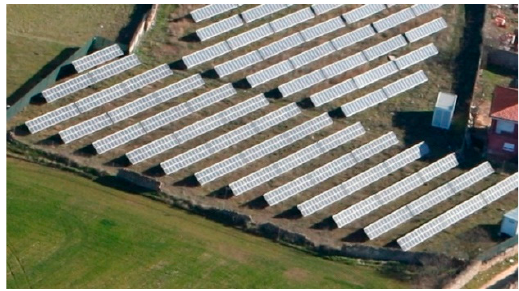
Figure 3. System 2 facility located at Torquemada (Palencia). One-axis, manual stational tilt.